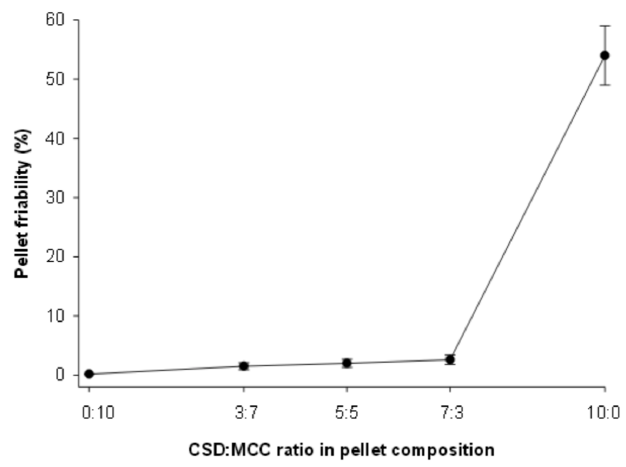
Figure 6. Pellet friability (%) against the ratio CSD:MCC.